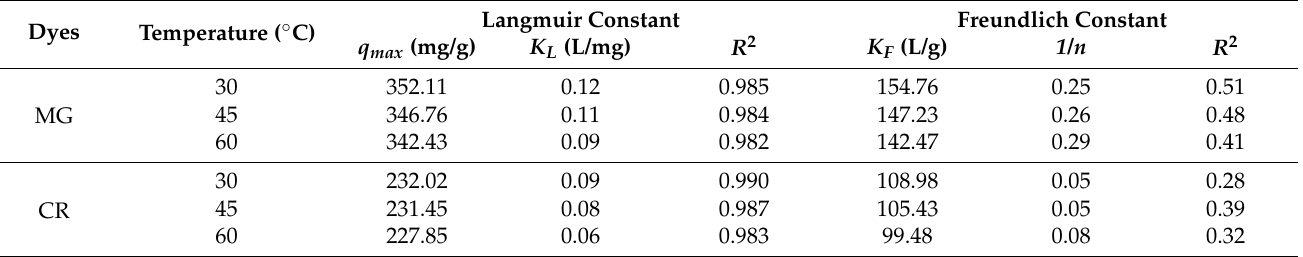
Figure 5. The effects of the initial dyes concentration ( a ), the Langmuir isotherm model ( b ). Table 1. Langmuir and Freundlich adsorption isotherms constants for the adsorption of both reactive dyes on DMAL.